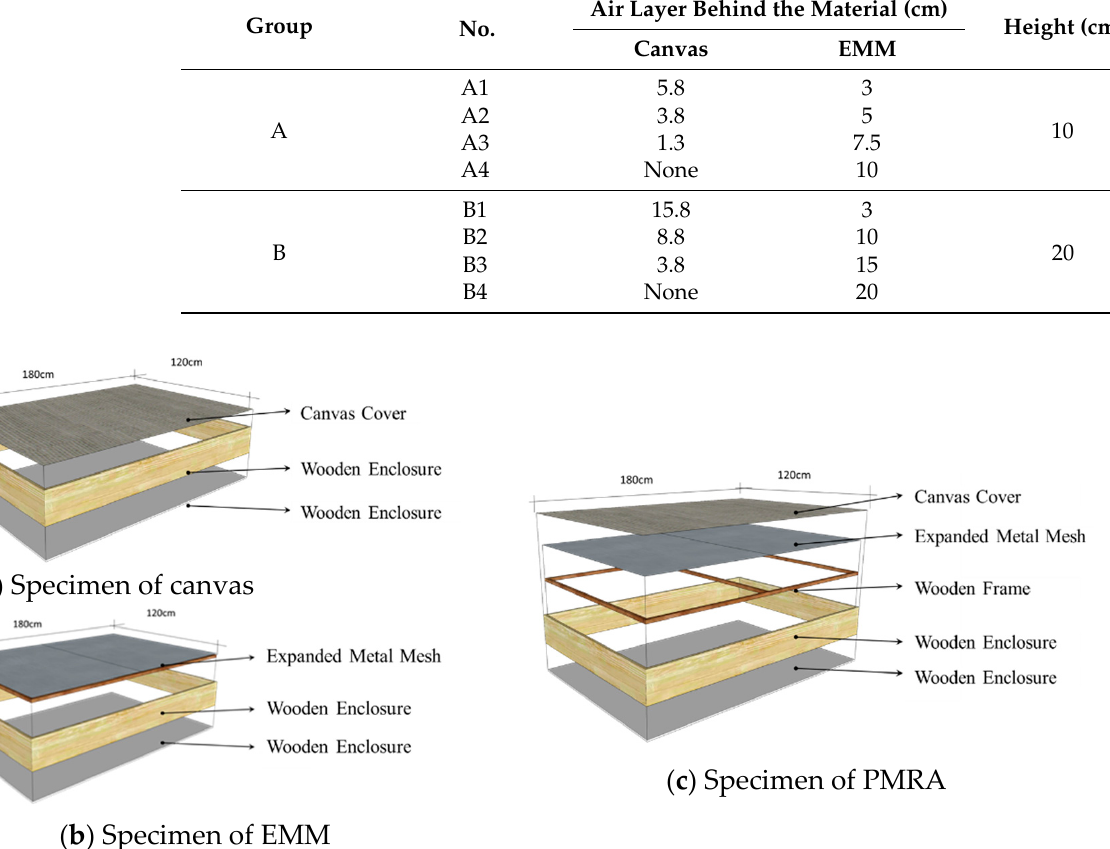
Figure 2. Composition of specimens. Table 1. Detailed thickness of stage 1 specimens.